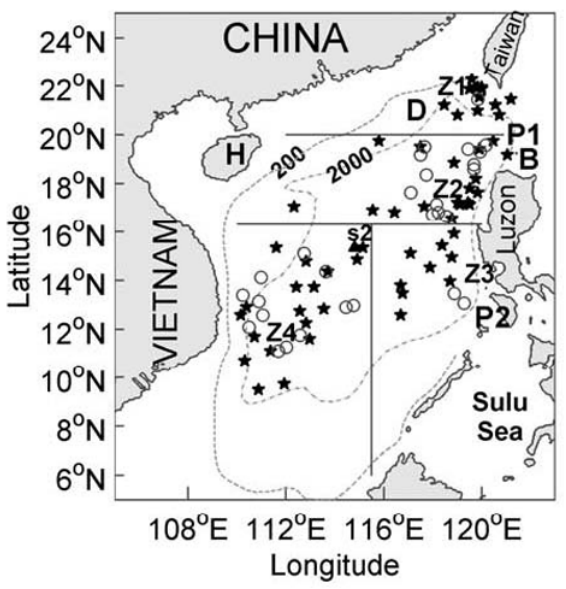
Fig. 5. Four geographic zones of SCS, adopted from Wang et al. (2003). Circles denote cyclonic eddies, and stars anticyclonic